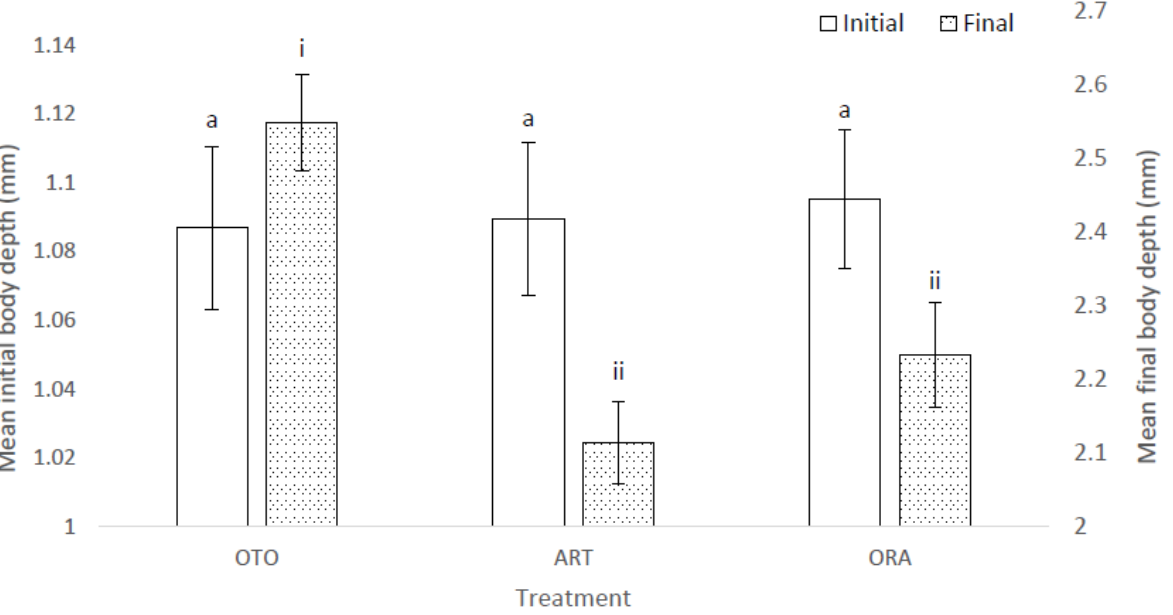
Figure 3. Mean initial and final b ody depth for larval giant kōkopu in three different feed treatments; OTO (Otohime), ART (Artemac) and ORA (O.range) (mean ± SE). Means with different superscripts are significantly different among treatments for mean initial body depth and among treatments for mean final body depth ( p < 0.05).